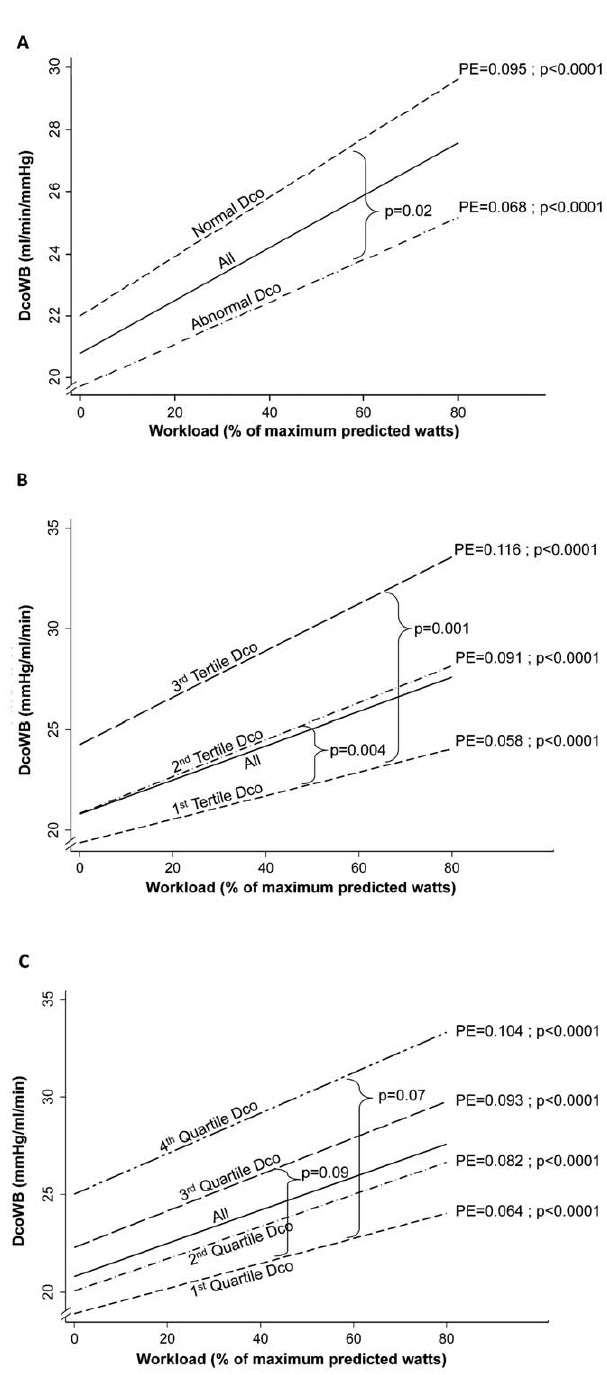
Figure 2. Association between within breath diffusing capacity (DcoWB) and workload. Generalized estimating equations were used to create linear regressions representing each association. Exercise- induced increase in diffusing capacity is decreased in flight attendants with lower diffusing capacity at rest. A: Stratification based on abnormal and normal diffusing capacity at rest. B: Stratification based on tertiles of diffusing capacity at rest. C: Stratification based on quartiles of diffusing capacity at rest. PE: Parameter estimate from regression models.